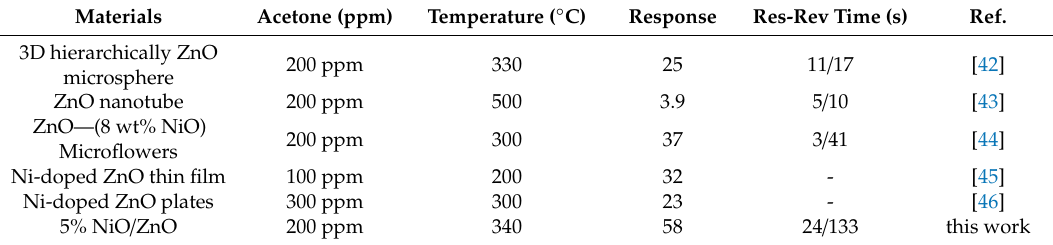
Figure 3. ( a ) Temperature-dependent responses of the samples towards 500 ppm acetone, ( b ) response of 5% NiO / ZnO to various gases at 340 ◦ C. Table 1. Comparison of the gas sensing characteristics to acetone of various